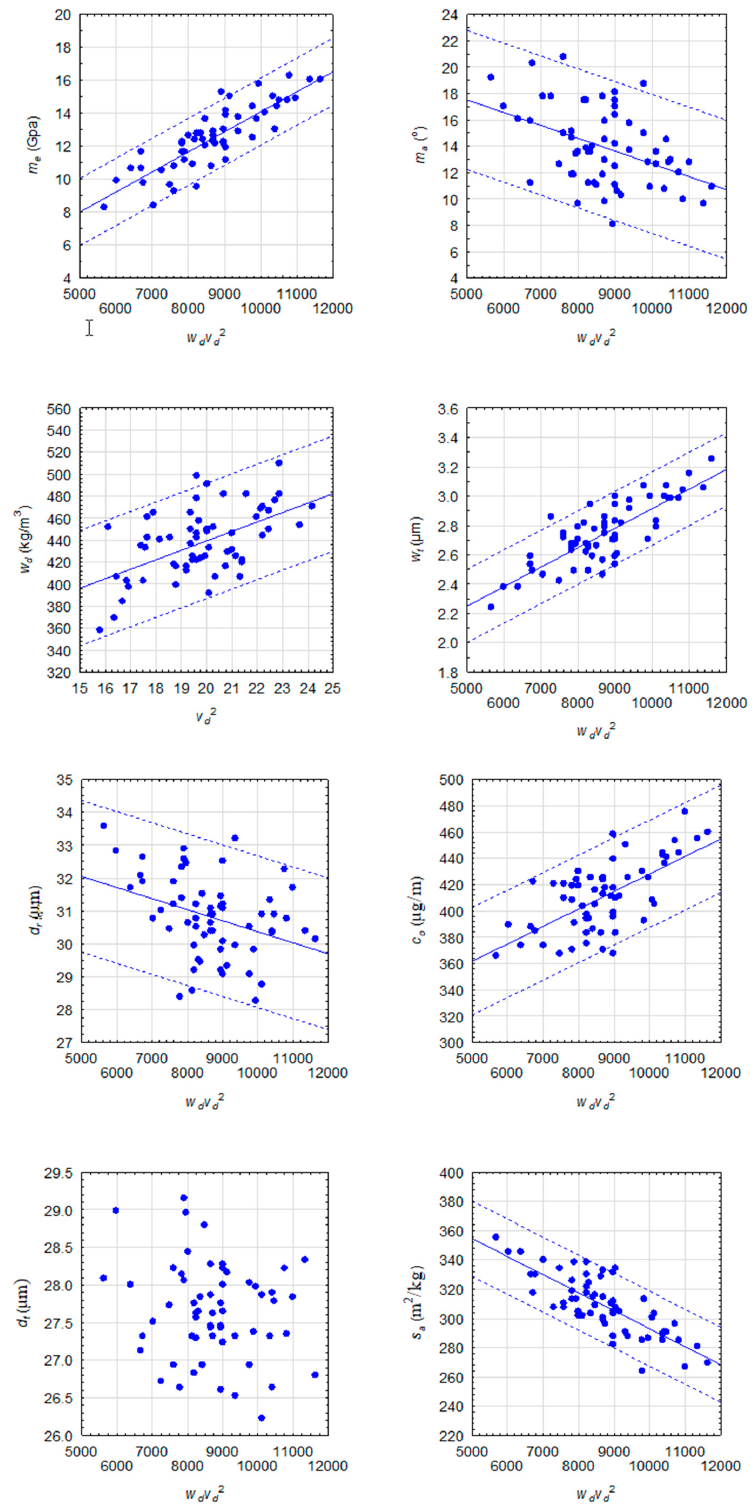
Figure 2. Attribute-specific acoustic relationships with significant ( p ≤ 0.05) regression relationships 1 superimposed (solid line, Equations (5a) and (5b), Table 4) for dynamic modulus of elasticity (cid:16) (cid:17)(cid:17) (cid:16) (cid:17)(cid:17) (cid:16) (cid:17)(cid:17) m e = f ( w d v 2 w d = f ( v 2 m a = f ( w d v 2 , wood density , microfibril angle , tracheid wall thickness d d d (cid:16) (cid:17)(cid:17) (cid:16) (cid:17)(cid:17) w t = f ( w d v 2 d r = f ( w d v 2 , radial tracheid diameter , tangential tracheid diameter, fibre coarseness, d d and specific surface area. Denoted by the superimposed dashed parallel lines are the 95% prediction limits for absolute error (Equation (10), Table